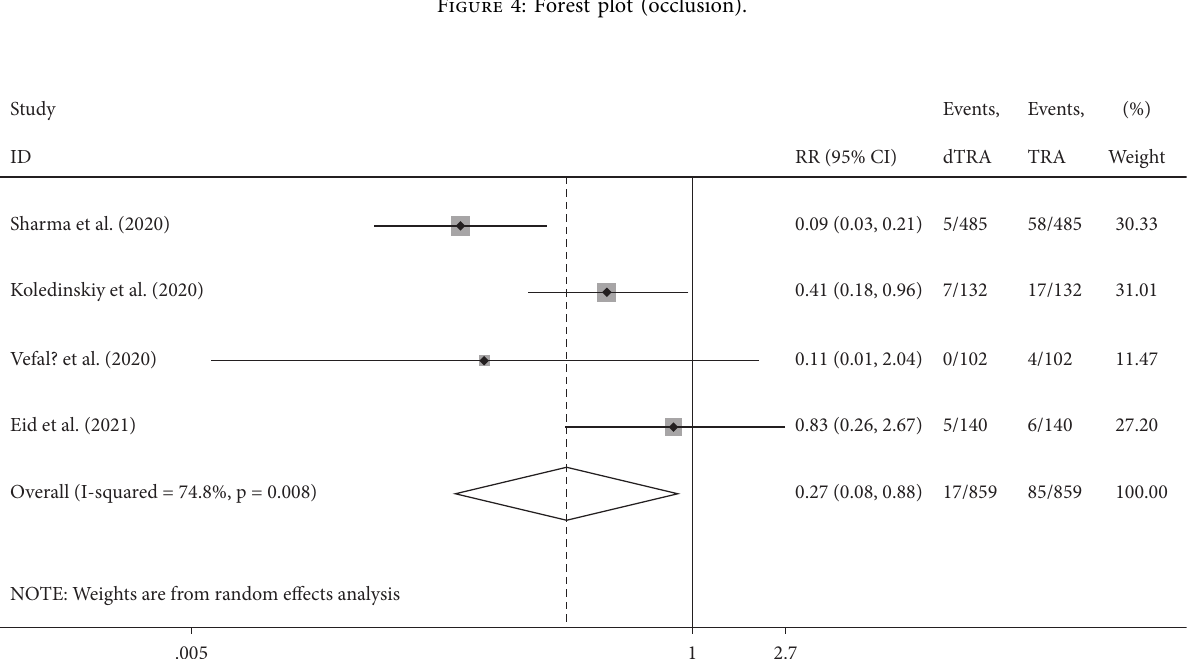
Figure 4: Forest plot